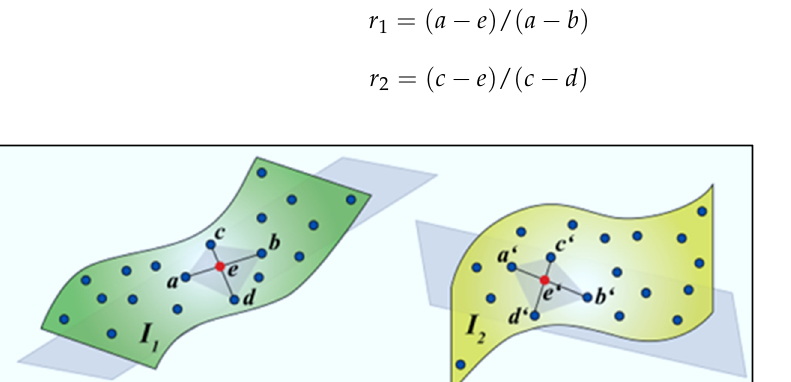
Figure 7. Principle of point selection in four-points congruent sets (4PCS) algorithm (adapted from [39,40]).